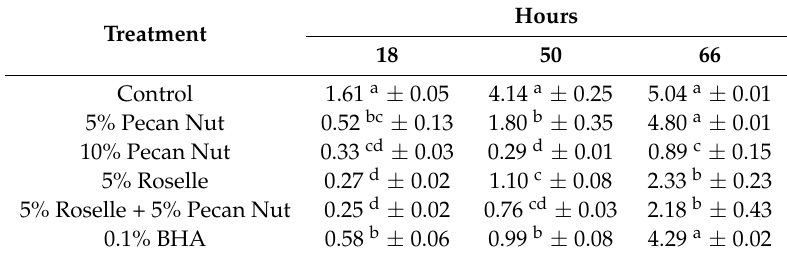
Figure 1. Evolution of TBARS value 1 (7 ± 1 °C) in Sardina pilchardus samples with different treatments in a period of 66 h. 1 Results are expressed in mg MDA/kg. Table 3. Evolution of TBARS values (mg MDA/kg) 1 in Sardina pilchardus samples at 18, 50 and 66 h of incubation at 7 ± 1 °C.